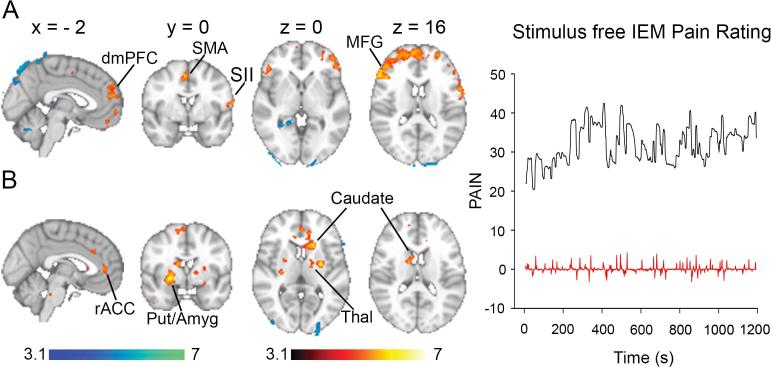
Brain activity associated with stimulus-free pain in patients with IEM due to the S241T Nav1.7 mutation. Areas in red to yellow exhibit significant increase in brain activity during pain rating while areas in blue to light blue exhibit significant increase in brain activity during visual rating (a) Brain activity during stimulus-free pain rating; an example rating is shown on the right in black. (b) Brain activity during periods of change of stimulus-free pain (i.e. derivative of pain rating). An example rating is shown on the right in red. The timeserie in red is the derivative of the pain timeserie depicted in black. Abbreviations: Amyg, amygdala; Put, putamen; rACC, rostral anterior cingulate cortex Thal, thalamus. (For interpretation of the references to color in this figure legend, the reader is referred to the web version of this article.)